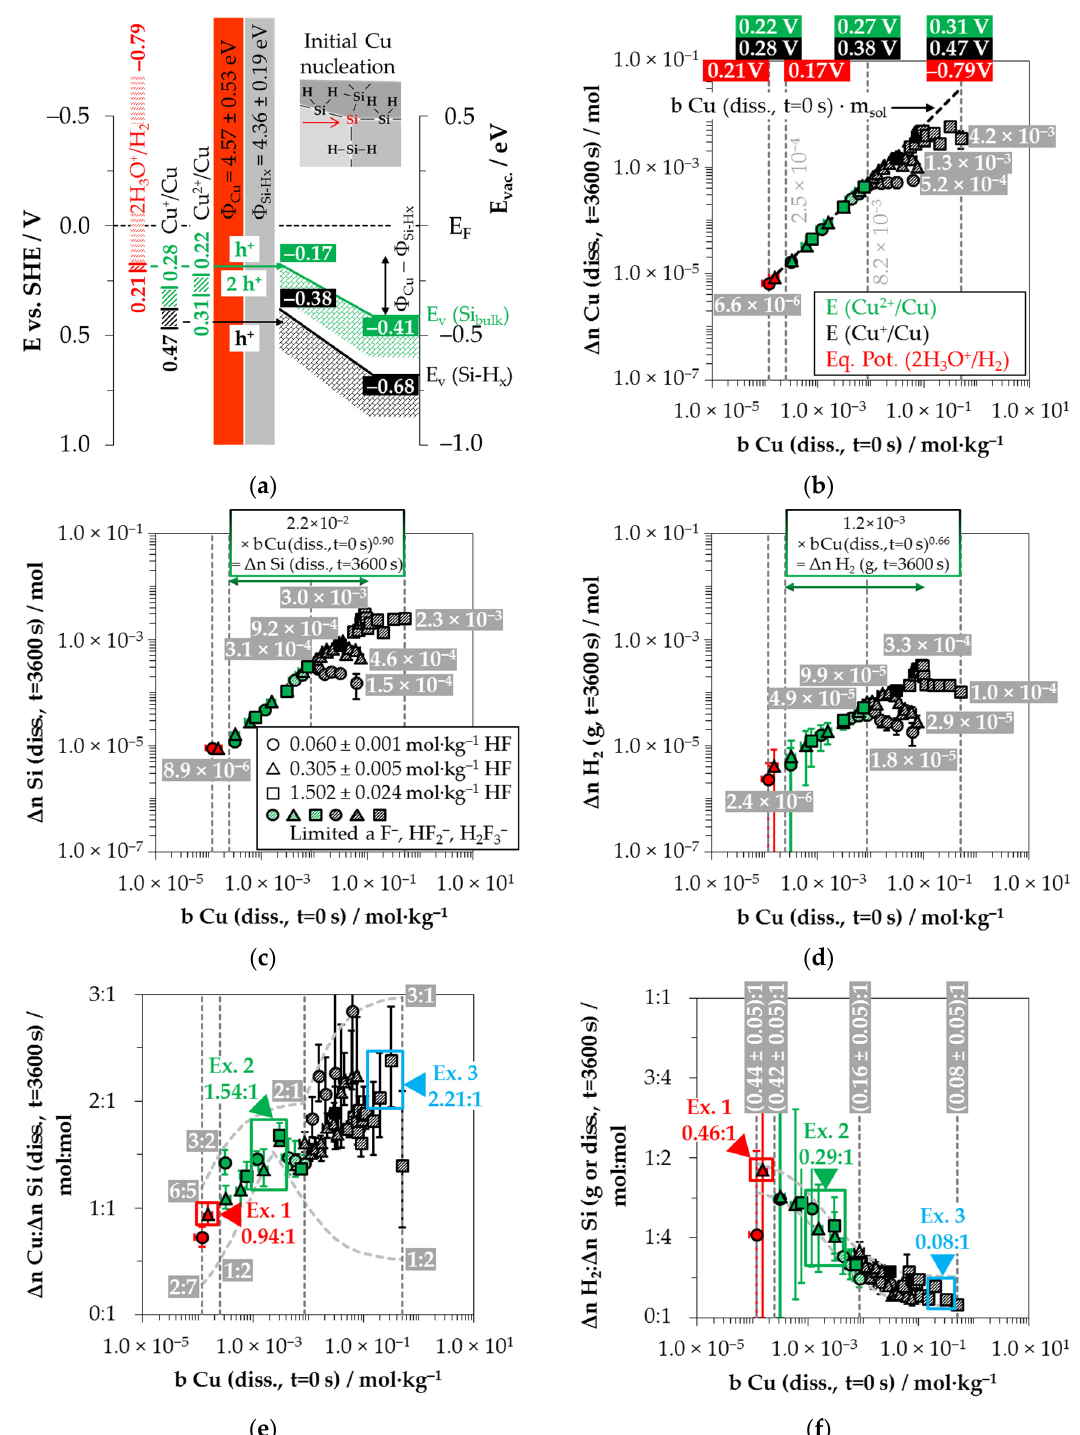
Figure 6. ( a ) Energy diagram of Cu 2+ /Cu + and H 3 O + reduction at the Cu/Si contact with the indication of the upper and lower limits of the redox strengths of the Cu 2+ /Cu and Cu + /Cu half-cells [28] and those of the equilibrium potentials of the 2H 3 O + /H 2 half-cell [33] and energetic levels of the valence bands of the bulk and hydrogen-terminated silicon ( E V (Si bulk ) [26,80,81], E V (Si-H x ) [82]) and their bending based on the differences of Φ Cu and Φ Si-Hx [83–88] and the findings from [26], ( b ) amounts of Cu deposition ( Δ n Cu ( diss., t = 3600 s)); ( c ) Si dissolution ( Δ n Si ( diss., t = 3600 s)) and ( d ) molecular H 2 formation ( Δ n H 2 ( g, t = 3600 s)) after t = 3600 s processing, as well as stoichiometric ratios of ( e ) Cu deposition and Si dissolution ( Δ n Cu : Δ n Si ( diss., t = 3600 s)) and ( f ) stoichiometric ratios of molecular H 2 formation and Si dissolution ( Δ n H 2 : Δ n Si ( g or diss., t = 3600 s)) relative to the initial Cu 2+ molality b Cu ( diss., t = 0 s).